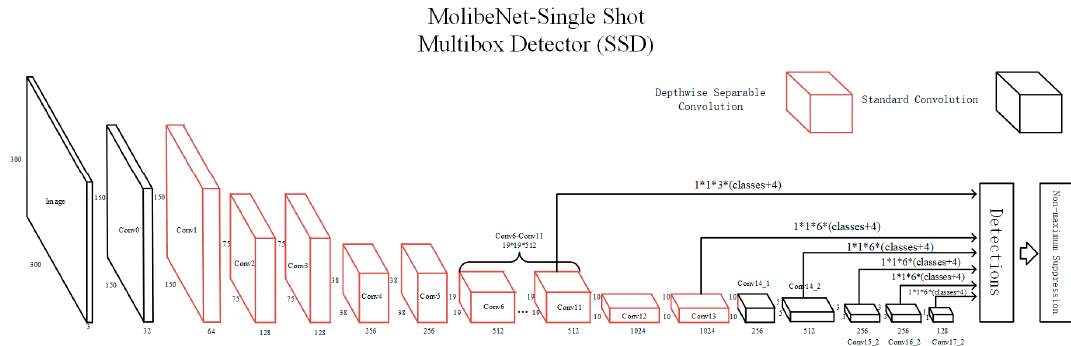
Figure 7. The network architecture of the MobileNet Single Shot Multibox Detector (SSD). Figure 6. The network architecture of the MobileNet Single Shot Multibox Detector